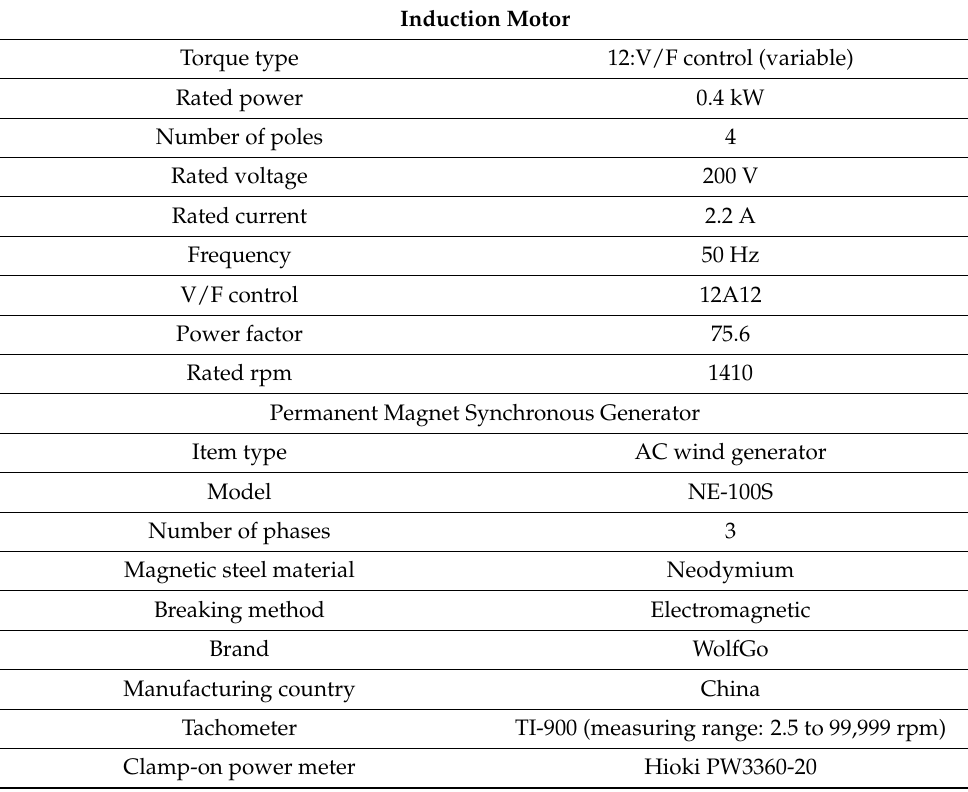
Table 2. Technical specifications of the experimental system used in this